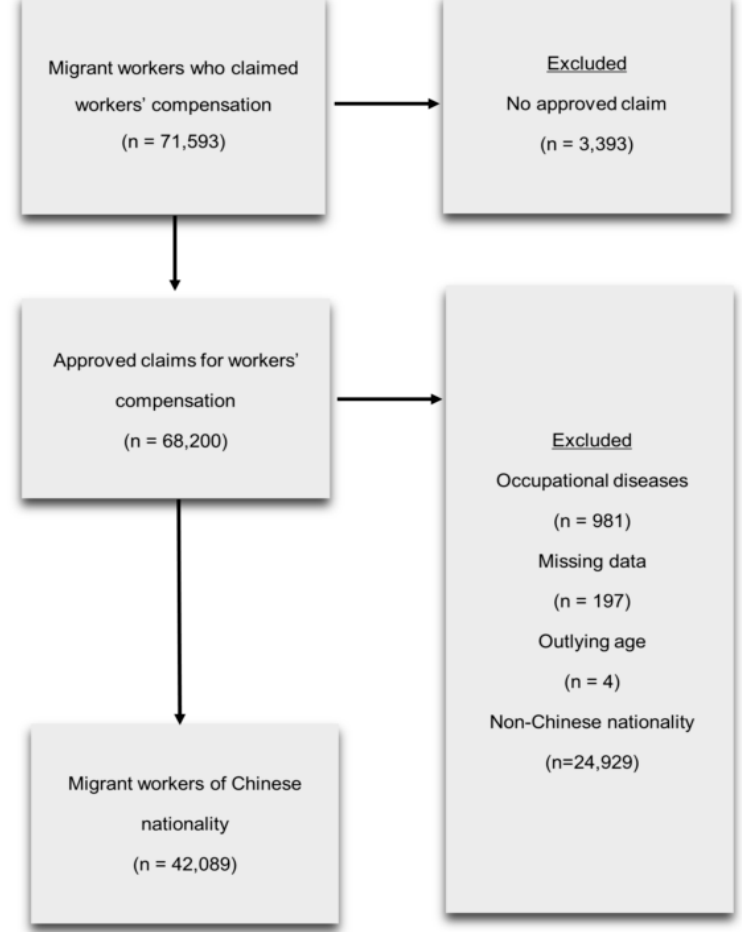
Figure 1. Selection of the study population.